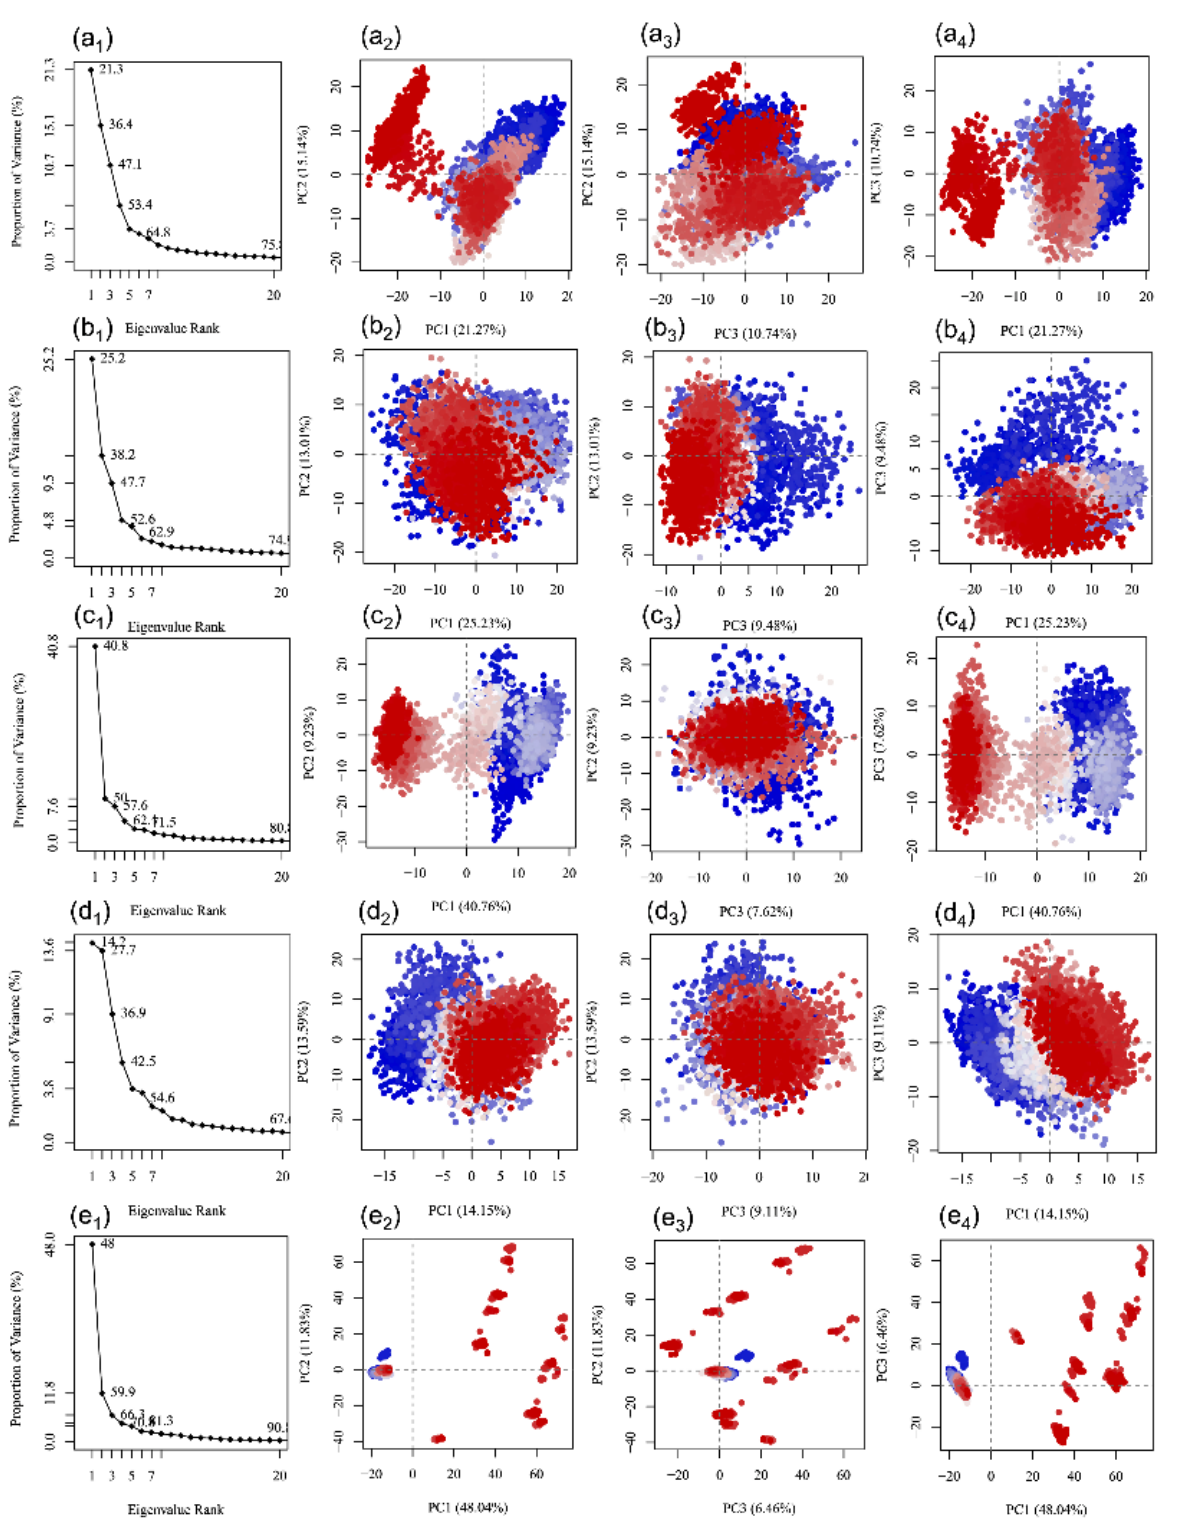
Figure 9. Principal component analysis for SARS-CoV-2 docked complexes with natural products, i.e., ( a ) Echinacoside, ( b ) Quercetagetin 7-glucoside, ( c ) Levan N, ( d ) Inulin from chicory, and ( e ) 1,3-Dicaffeoylquinic acid. The change from blue to red through white color in respective scatter plots shows the periodic jumps in the different conformations of the viral protease during 100 ns MD simulation intervals.